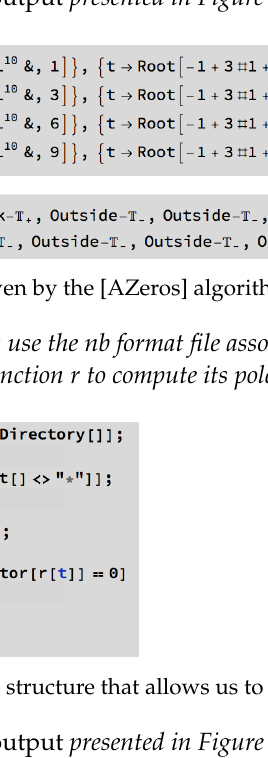
Figure 42. Part of the structure that allows us to compute and locate zeros of r . We obtain the output presented in Figure 43.